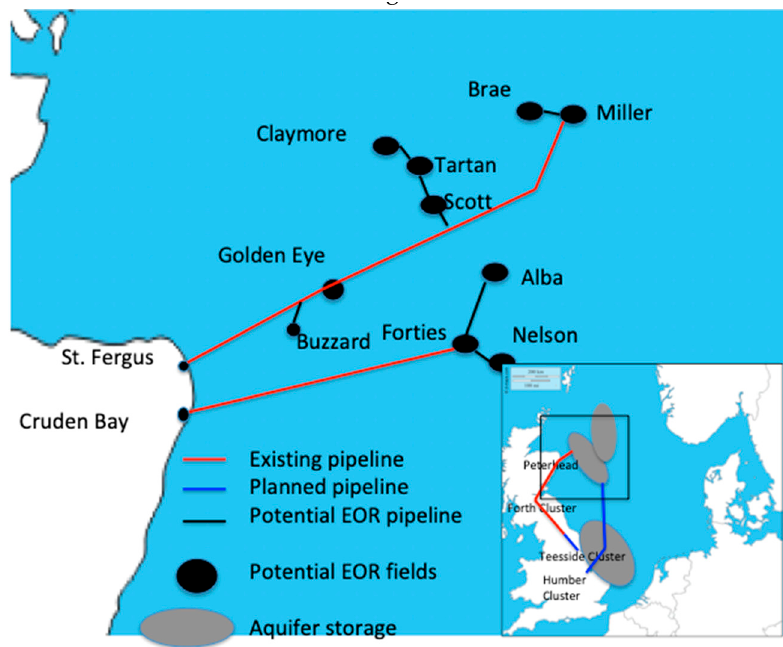
Figure 6. The conceptual vision of CO 2 storage beneath the North Sea, linked to emission sources with capture. The main map, simplified from Reference [17], shows fields in the UK Central North Sea that have been found particularly suitable technically and economically for CO 2 -EOR. Insert: Simplified from Scottish carbon capture and storage (SCCS) [9].